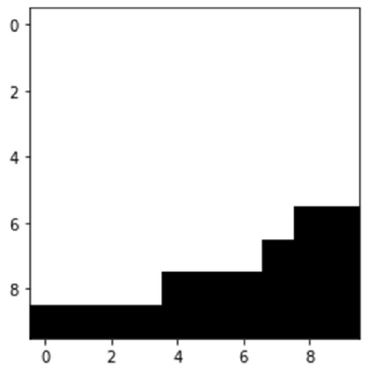
Figure 5. First sectioned region to analyze the position of the inlet path.